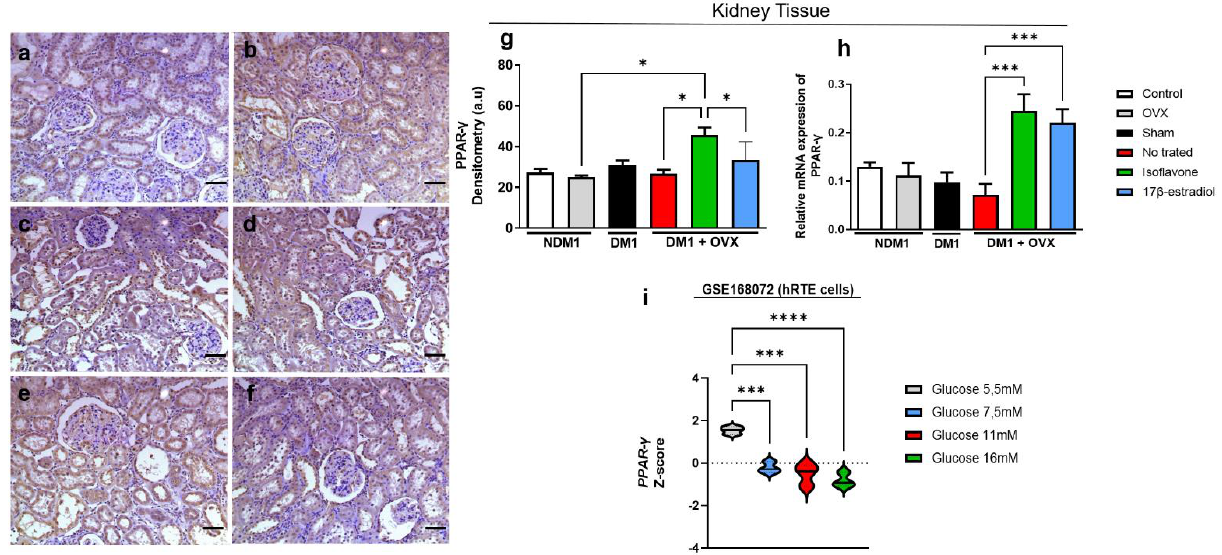
Figure 3. Isoflavone induces PPAR- γ in the kidneys. Immunoreactivity of PPAR- γ by immunohisto- chemistry ( a – f ). Control ( a ), OVX ( b ), DM1 ( c ), untreated DM1 + OVX ( d ), DM1 + OVX treated with isoflavone ( e ), and DM1 + OVX treated with 17 β -estradiol ( f ). Densitometry analysis is represented in arbitrary units ( g ). Scale bar = 50 µ m. mRNA expression of PPAR- γ , with B-actin gene as endogenous control. ( h ). Transcriptome analysis ( i ), Values represent mean ± SEM ( n = 6). Kruskal – Wallis